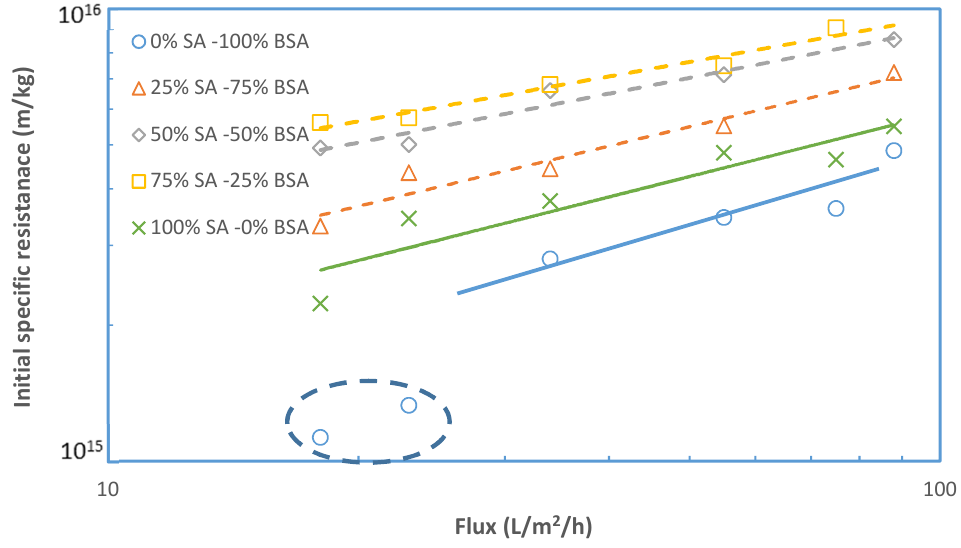
Figure 6. Initial fouling resistance α i values with respect to permeate flux J.